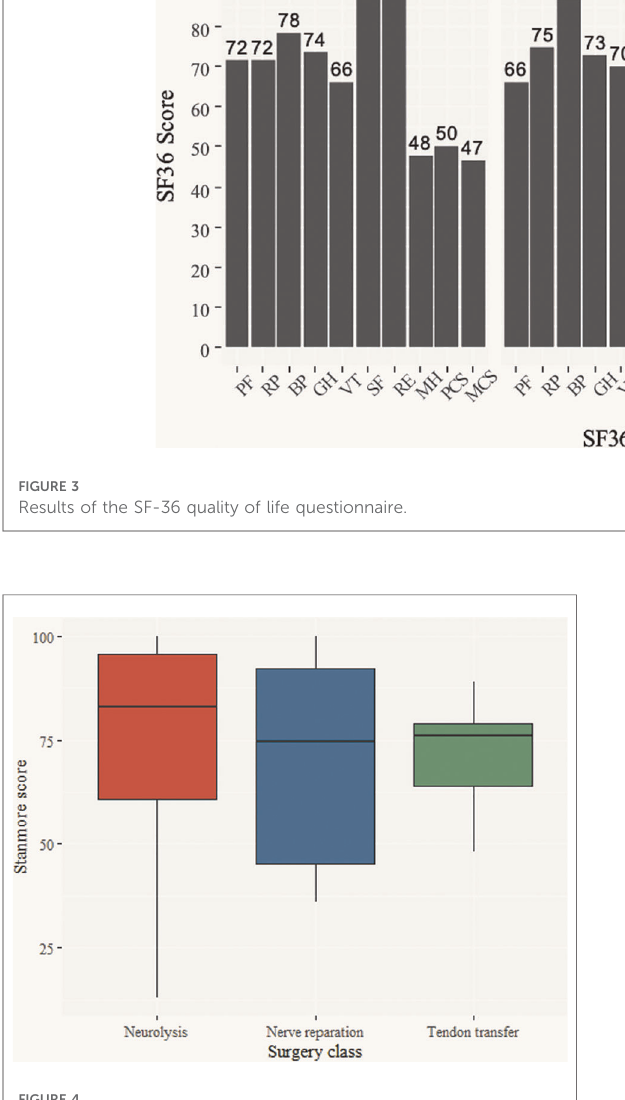
FIGURE 5 Stanmore grades among different surgical treatment